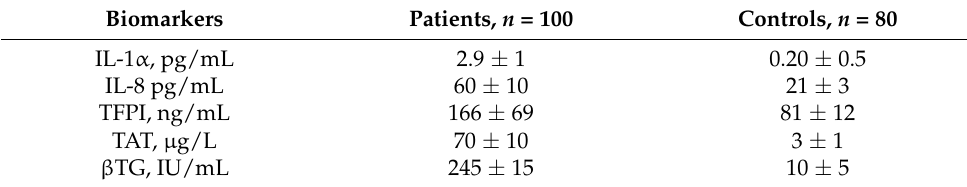
Table 2. Laboratory characteristics of coronavirus disease 2019 (COVID-19) patients. Biomarkers